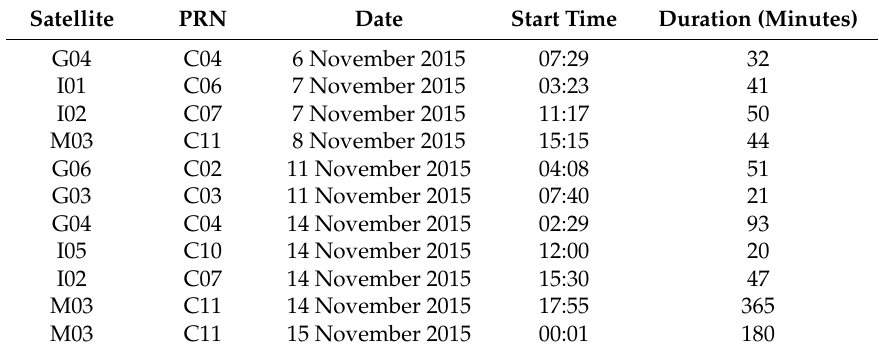
Table 3. List of Potential SIS Anomalies from 1 November 2015 to 27 December 2015. Satellite PRN